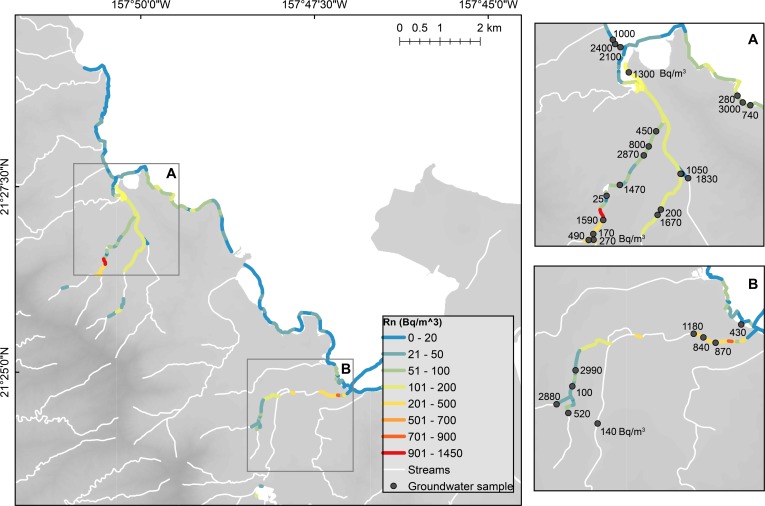
Non-modeled coastal and stream surface radon (Bq/m3) concentrations for Kāneʻohe Bay and studied streams (July sampling period).Stream surface radon concentrations (lines) and discrete (dots) groundwater radon concentrations are shown for (A) Kahaluʻu and ʻĀhuimanu and (B) Kāneʻohe areas.